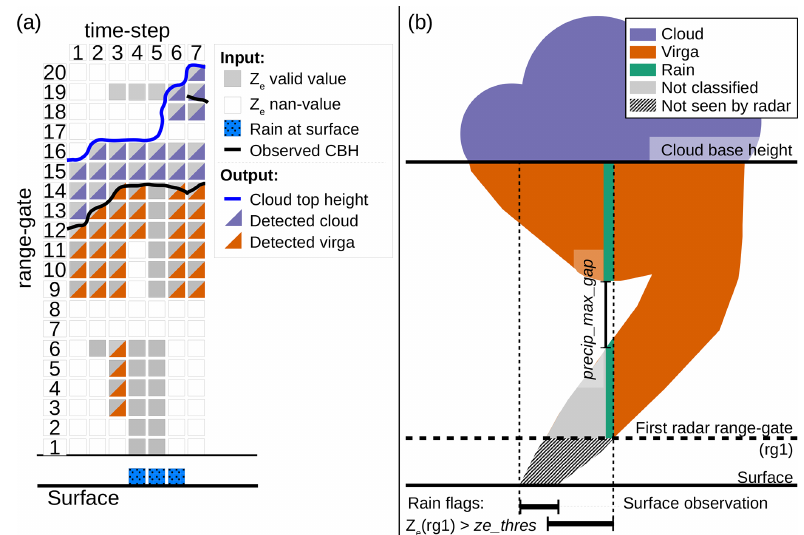
Figure 3. Illustration (not to scale) of cloud, precipitation and virga detection from radar reflectivity Z e , surface rain flag, and cloud base height data, corresponding to step 2 and 3 of Fig. 2. In panel (a) the behavior of the Virga-Sniffer in certain situations is shown in detail. Panel (b) shows the benefit and influence of different rain flags, as well as the threshold value of the rain gaps allowed